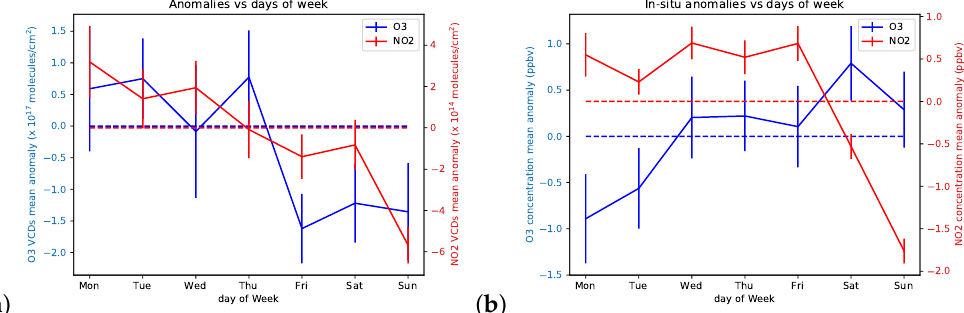
Figure 9. Mean anomalies of NO 2 and O 3 VCDs ( a ) and in situ concentrations ( b ) in each day of the week. The error bars are standard deviations of the means. The dashed lines represent the conditions with a null